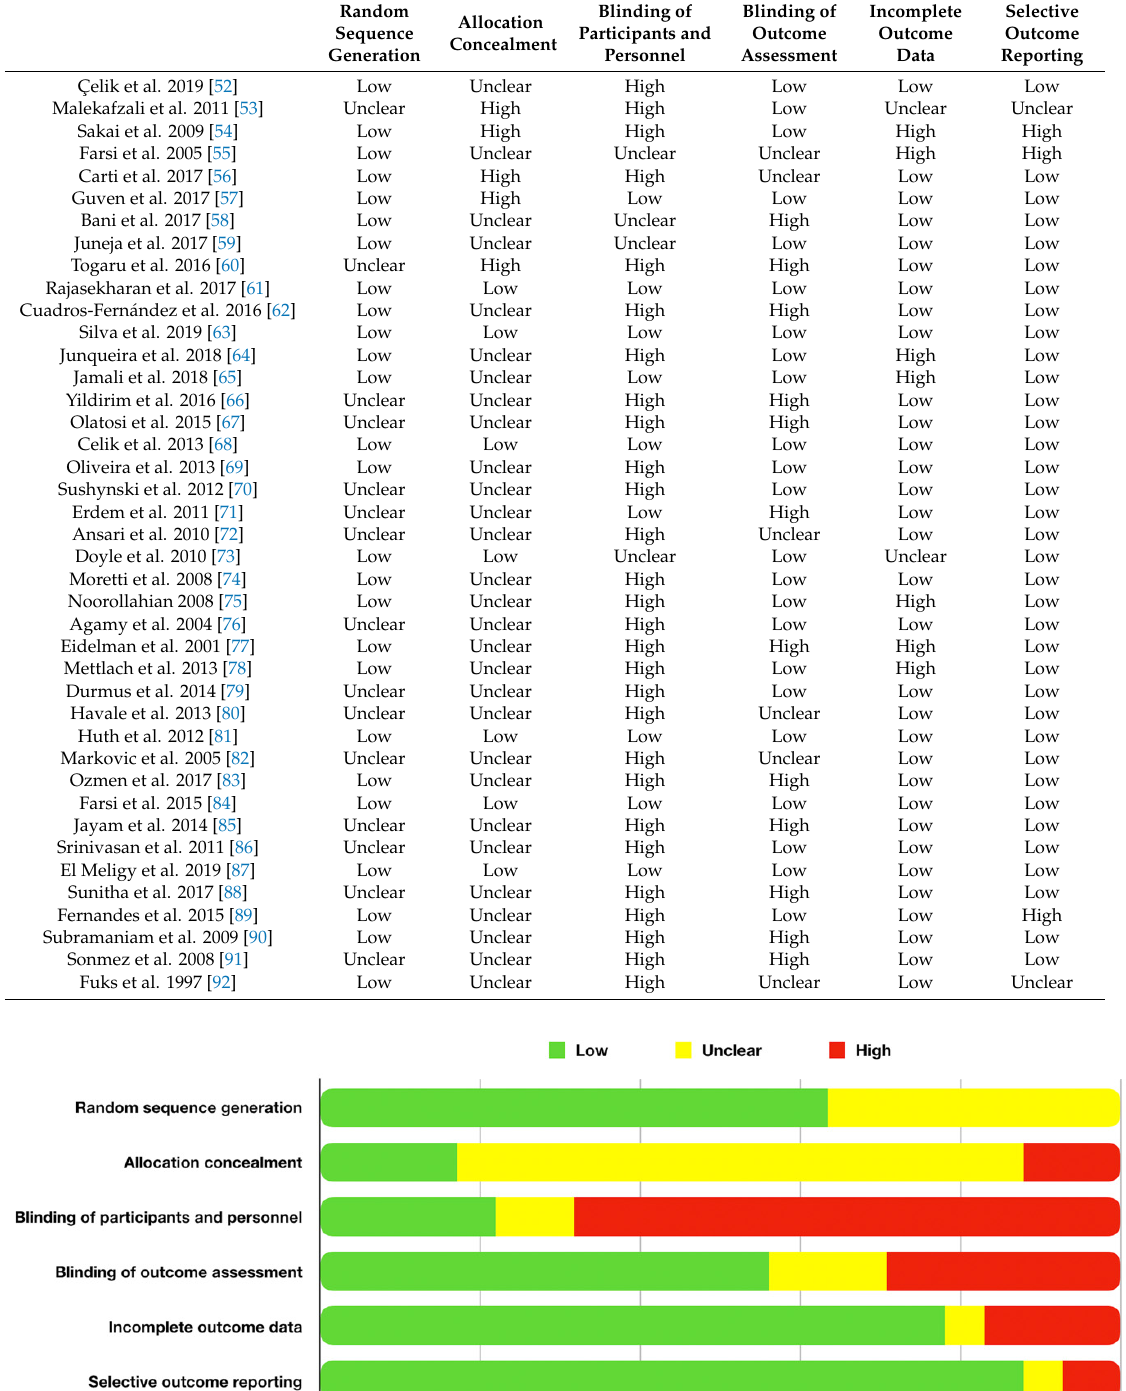
Table 2. Assessment of risk of bias of the included studies. Random Sequence